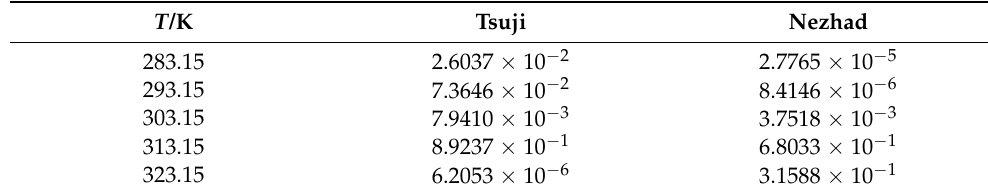
Table 13. Calculation results of ω i value of phenylglycine related solubility and pH